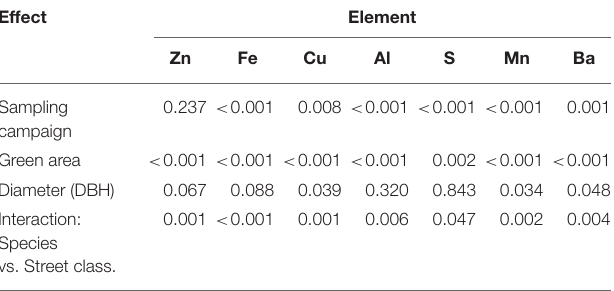
TABLE 2 | P values for effects in analysis of covariance models. TABLE 3 | Predicted Zn concentration means and standard errors (mg kg − 1 ) based on the ANCOVA